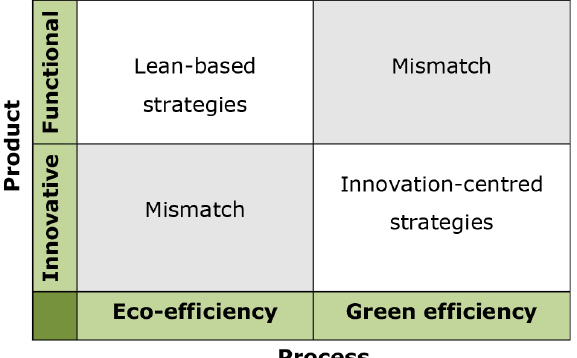
Figure 2. Product-Process characteristics and green